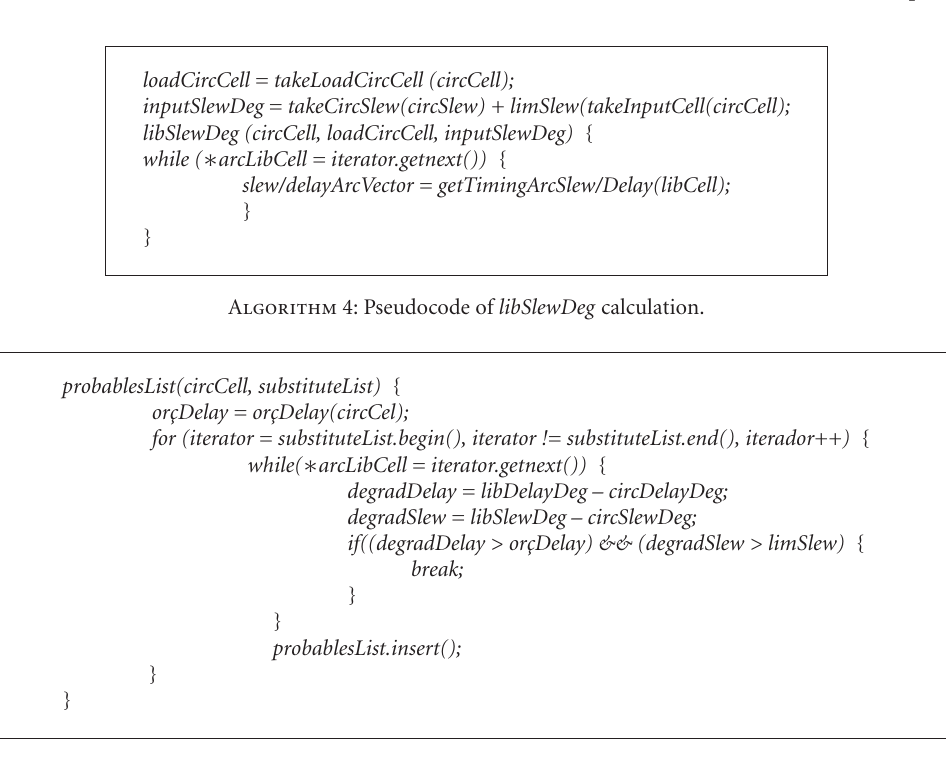
Algorithm 5: Pseudocode for determining the probable cells